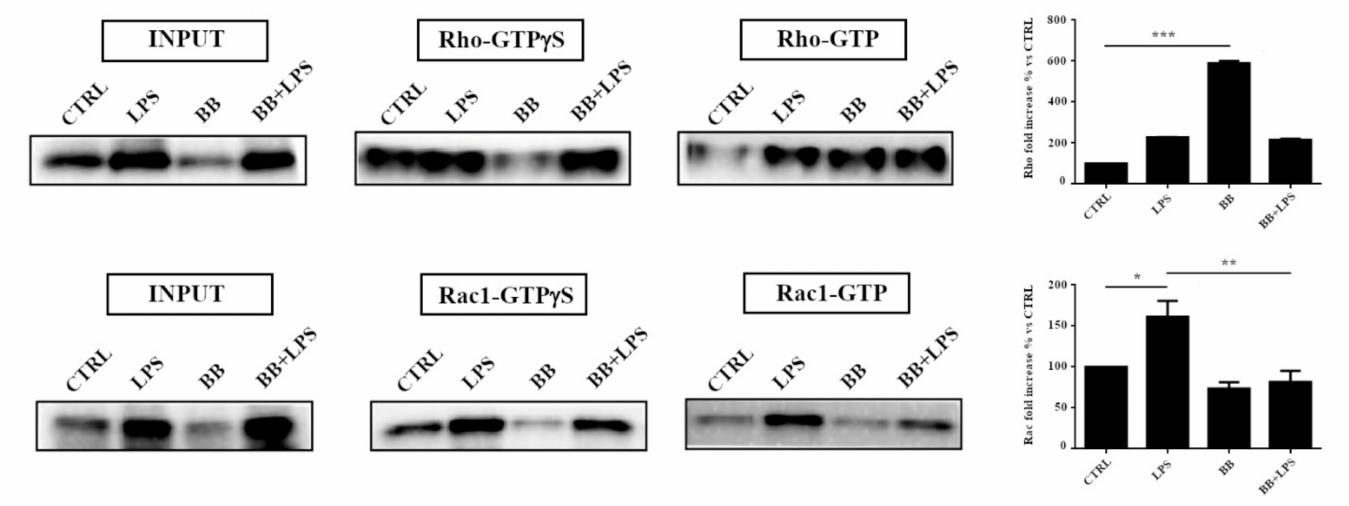
Figure 5. Pull down assay of Rho and Rac1 proteins. BV-2 cells treated with 10 ng / mL BB with or without LPS 100 ng / mL for 24 h. The pull down assay with GTP γ S was used as positive control. The results were reported as a percentage versus control. Densitometric analyses were performed with ImageLab software (Biorad) and normalized to INPUT. INPUT was normalized on the β -actin signal. The data are the ± SD average of three independent experiments. *** p < 0.001 BB compared to control, * p < 0.05 LPS compared to control, ** p < 0.01 BB + LPS compared to